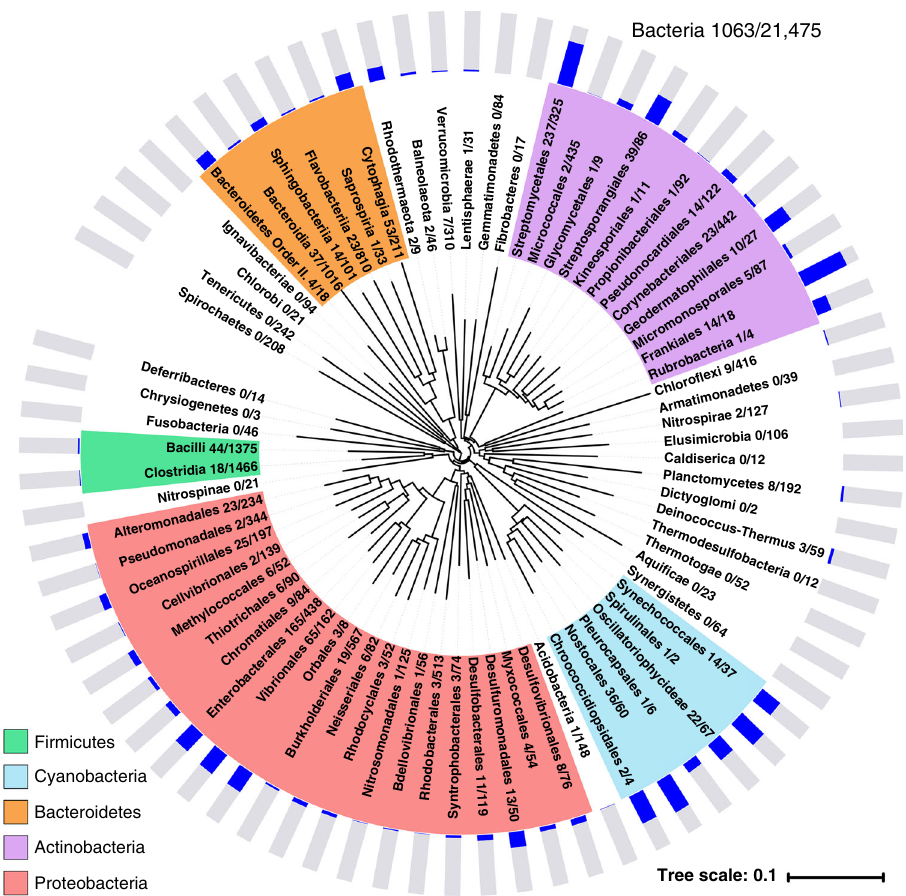
Fig. 5 Phylogenetic tree for prokaryotic ScoMcrA-SBD homologs. The two numbers behind each phylum/class/order represent the number of species possessing ScoMcrA-SBD homologs and that whose genomes have been sequenced. The occurrence frequency of ScoMcrA-SBD homologs, which was calculated by dividing the number of species possessing ScoMcrA-SBD homologs by the number of sequenced species, for different phyla/classes/orders in the bacteria kingdom was indicated. Details please see Supplementary Table